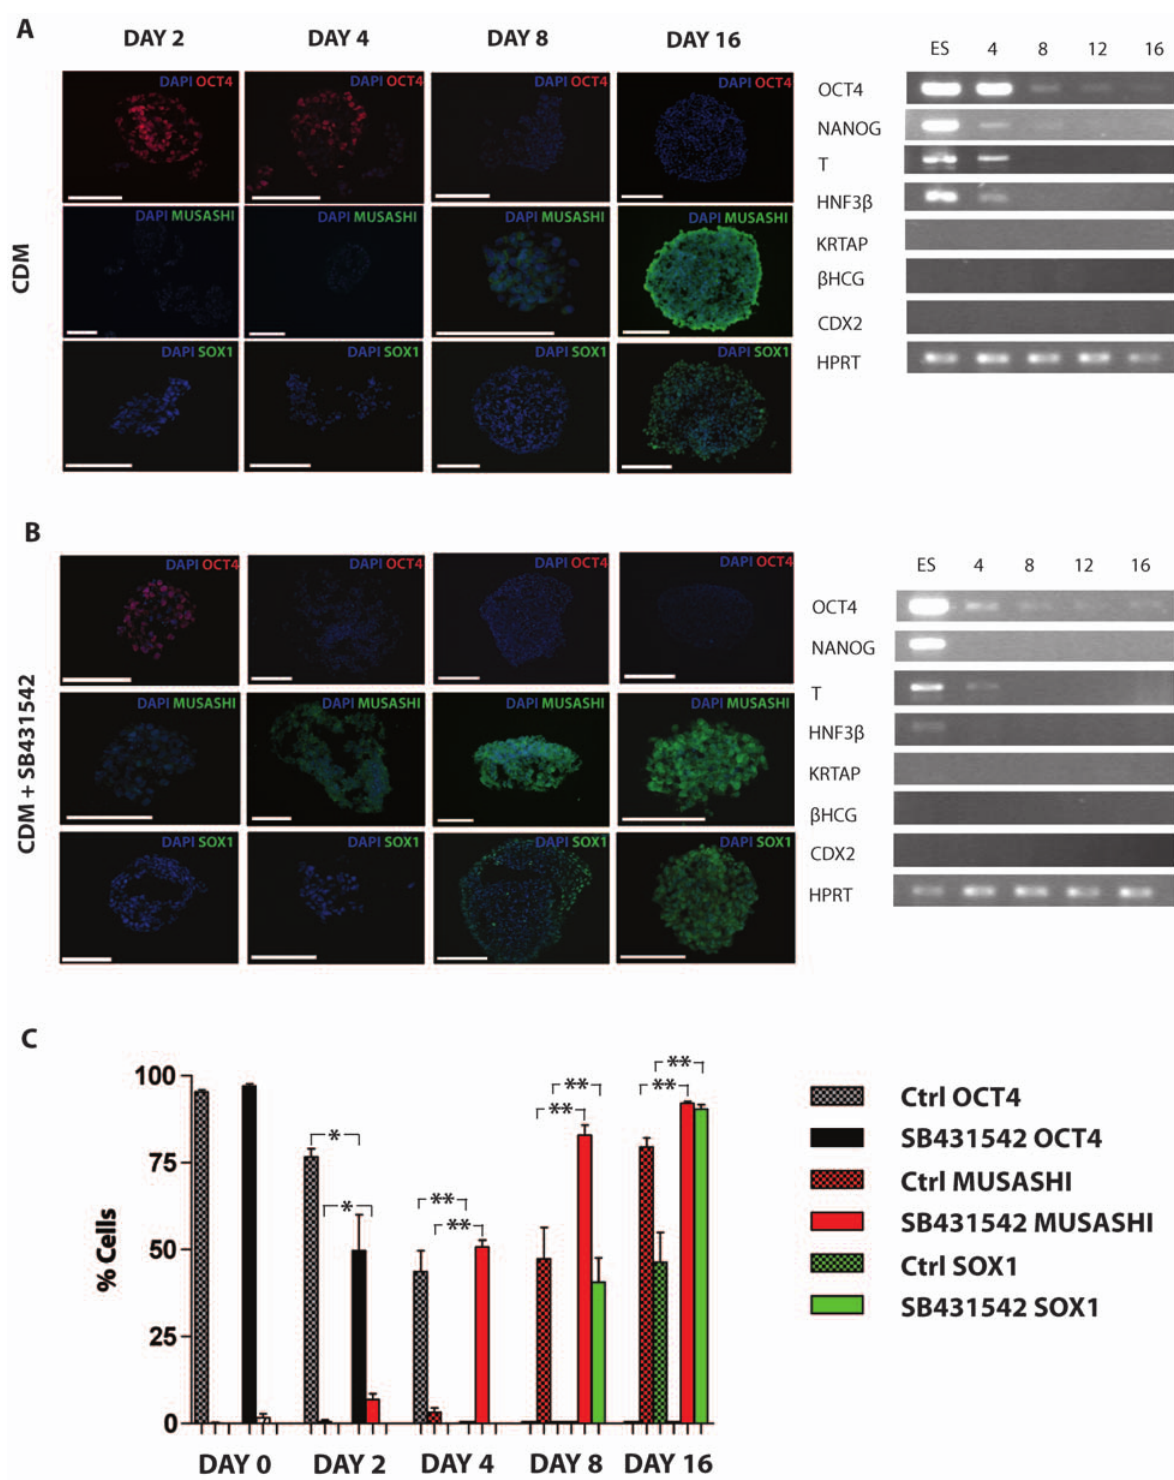
Figure 1. SB431542 accelerates neural induction from hESCs. Neural induction from hESCs using the HNM alone leads to loss of pluripotency markers OCT4 and NANOG by day 8 and concomitant acquisition of neuroectodermal markers MUSASHI (day 8) and SOX1 (day 16) by immunocytochemical analysis (A). Transcriptional analysis confirms loss of mesendodermal markers (T, HNF3 b ) by day 8 (A). SB431542 accelerates loss of pluripotency markers OCT4 and NANOG to day 4, and up-regulation of neural marker MUSASHI to day 4 and SOX1 to day 8 (B). RT-PCR confirms loss of mesendodermal markers (T, HNF3 b ) by day 8 and absence of epidermal marker (KRTAP) and trophectodermal markers ( b HCG, CDX2) in both control and SB431542 treated cells (B). Quantitative immunohistochemistry confirms significant acceleration in loss of pluripotency and expression of neural markers when using SB431542 compared to control (C). * =p , 0.05, ** P , 0.01, Scale bars: all 100 m m.